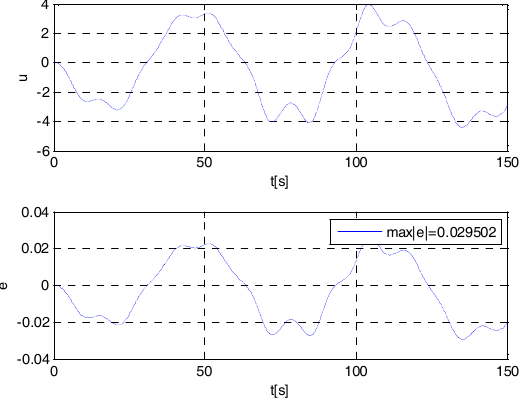
Figure 38. Time histories of , u e for 5 a .